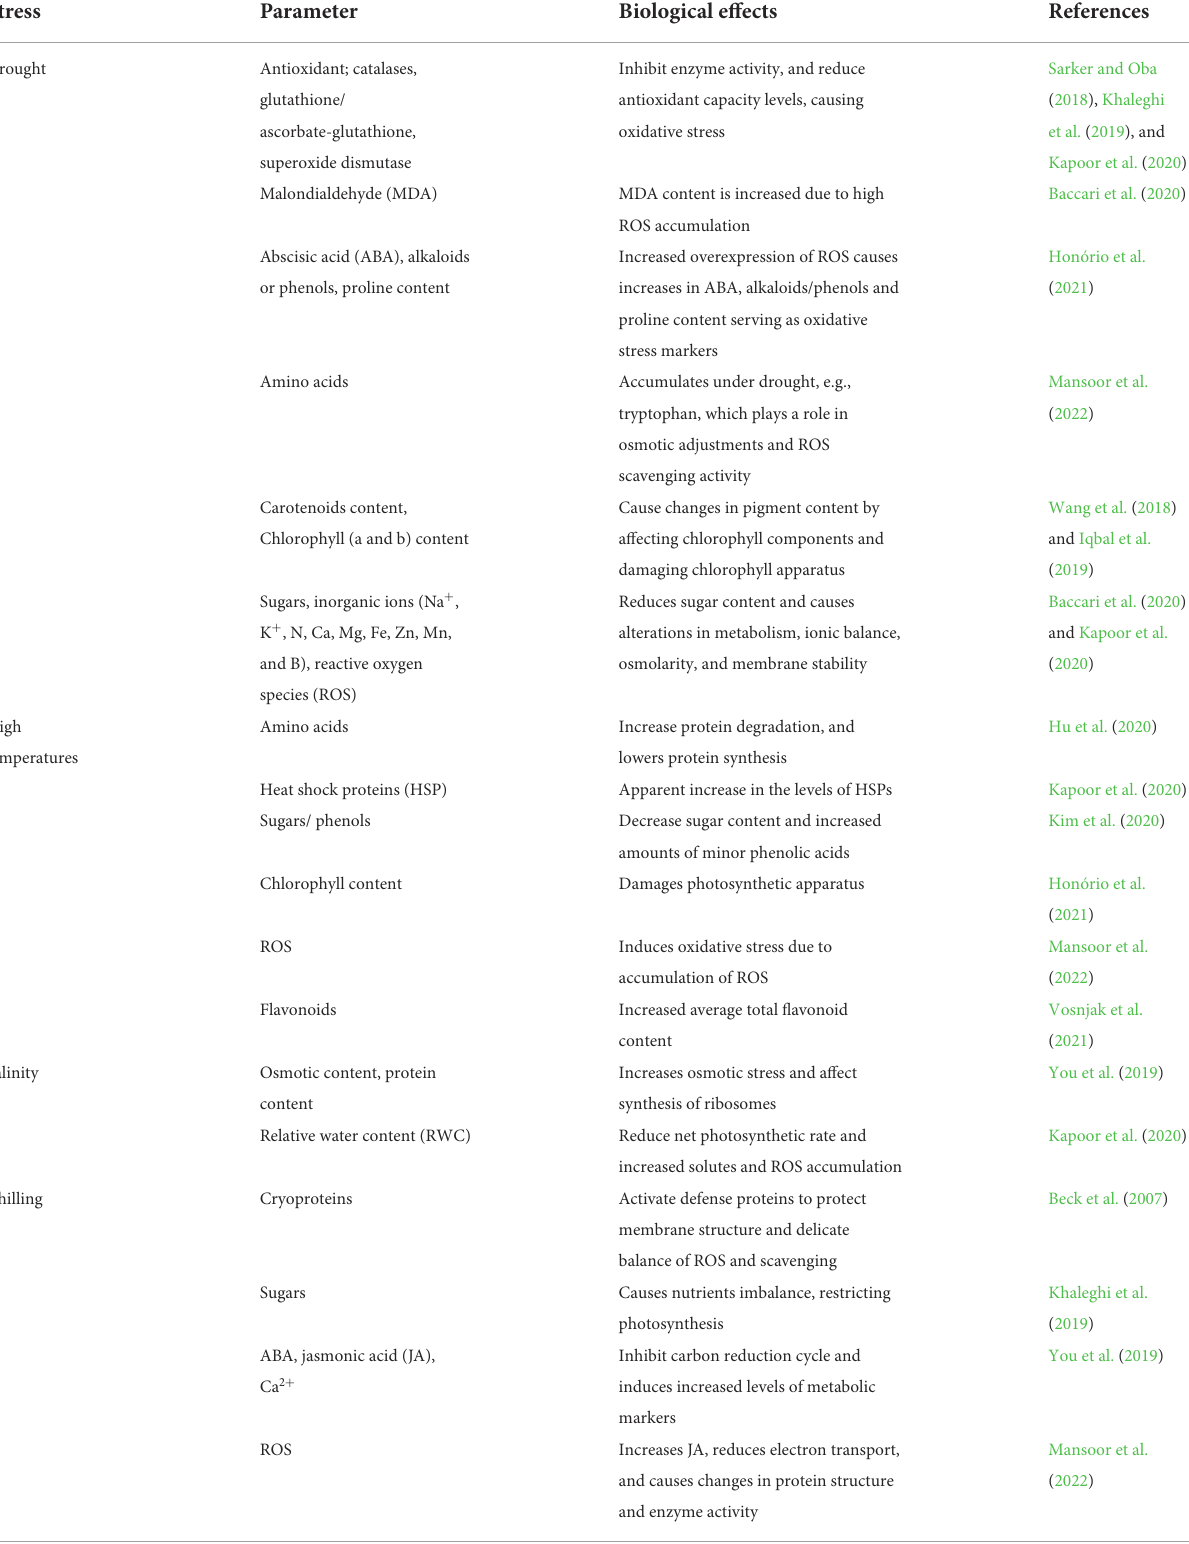
TABLE 1 General biochemical and physiological growth parameters influenced by different abiotic stress factors in